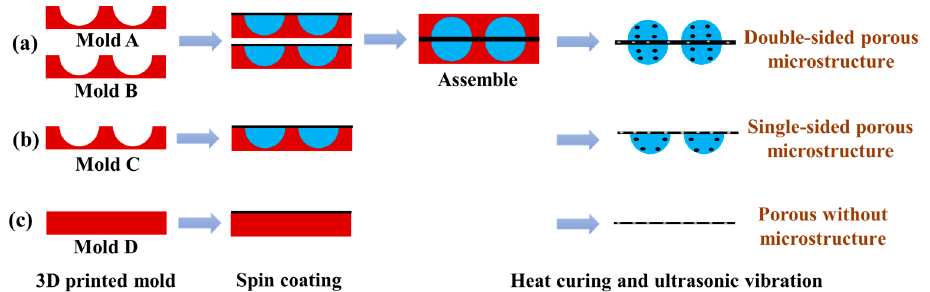
Figure 2. Fabrication process of dielectric layer. ( a ) The porous double-sided microstructure dielectric layer; ( b ) the porous single-sided microstructure dielectric layer; ( c ) the porous dielectric layer without microstructure.